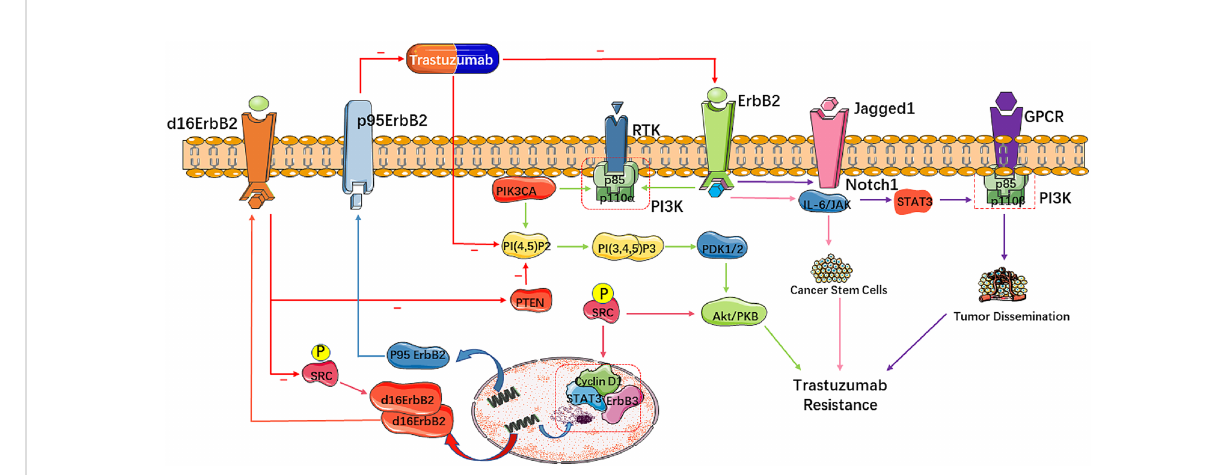
FIGURE 1 Molecular mechanisms of trastuzumab resistance in HER2-positive breast cancer. These molecular mutations mainly impact cell signaling and proliferation, leading to trastuzumab resistance. Alterations of HER2 in fl uencing downstream pathways abate the pharmacologic effect of trastuzumab. A truncated form of HER2 called p95-HER2 lacks the extracellular domain that binds trastuzumab and is related with poor response to trastuzumab. d16-HER2, derived from exon 16 skipping in ERBB2 , generates activated d16-HER2 homodimers on the tumor cell surface to activate SRC kinase, resulting in cell proliferation and tumorigenesis.